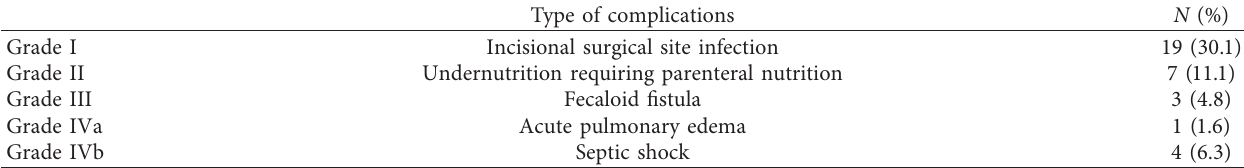
Table 4: Distribution of postoperative complications according to Clavien–Dindo.